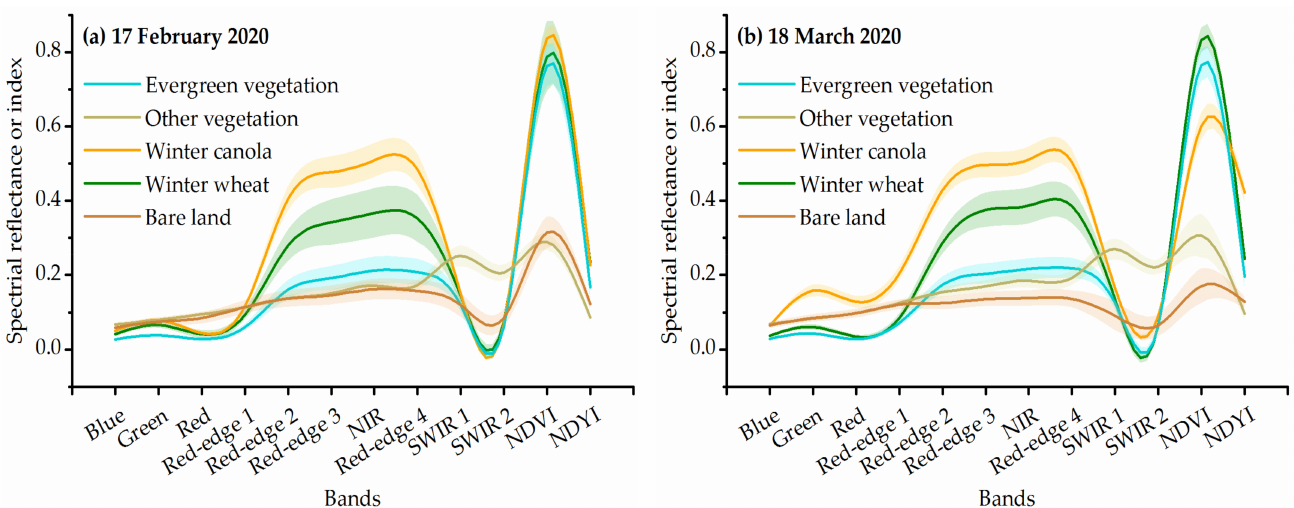
Figure 2. Spectral, NDVI and NDYI profiles derived from Sentinel-2 imagery on ( a ) 17 February 2020 and ( b ) 18 March 2020 (canola flowering period) in the first study region. Solid lines represent means and shaded areas represent one standard deviation from the